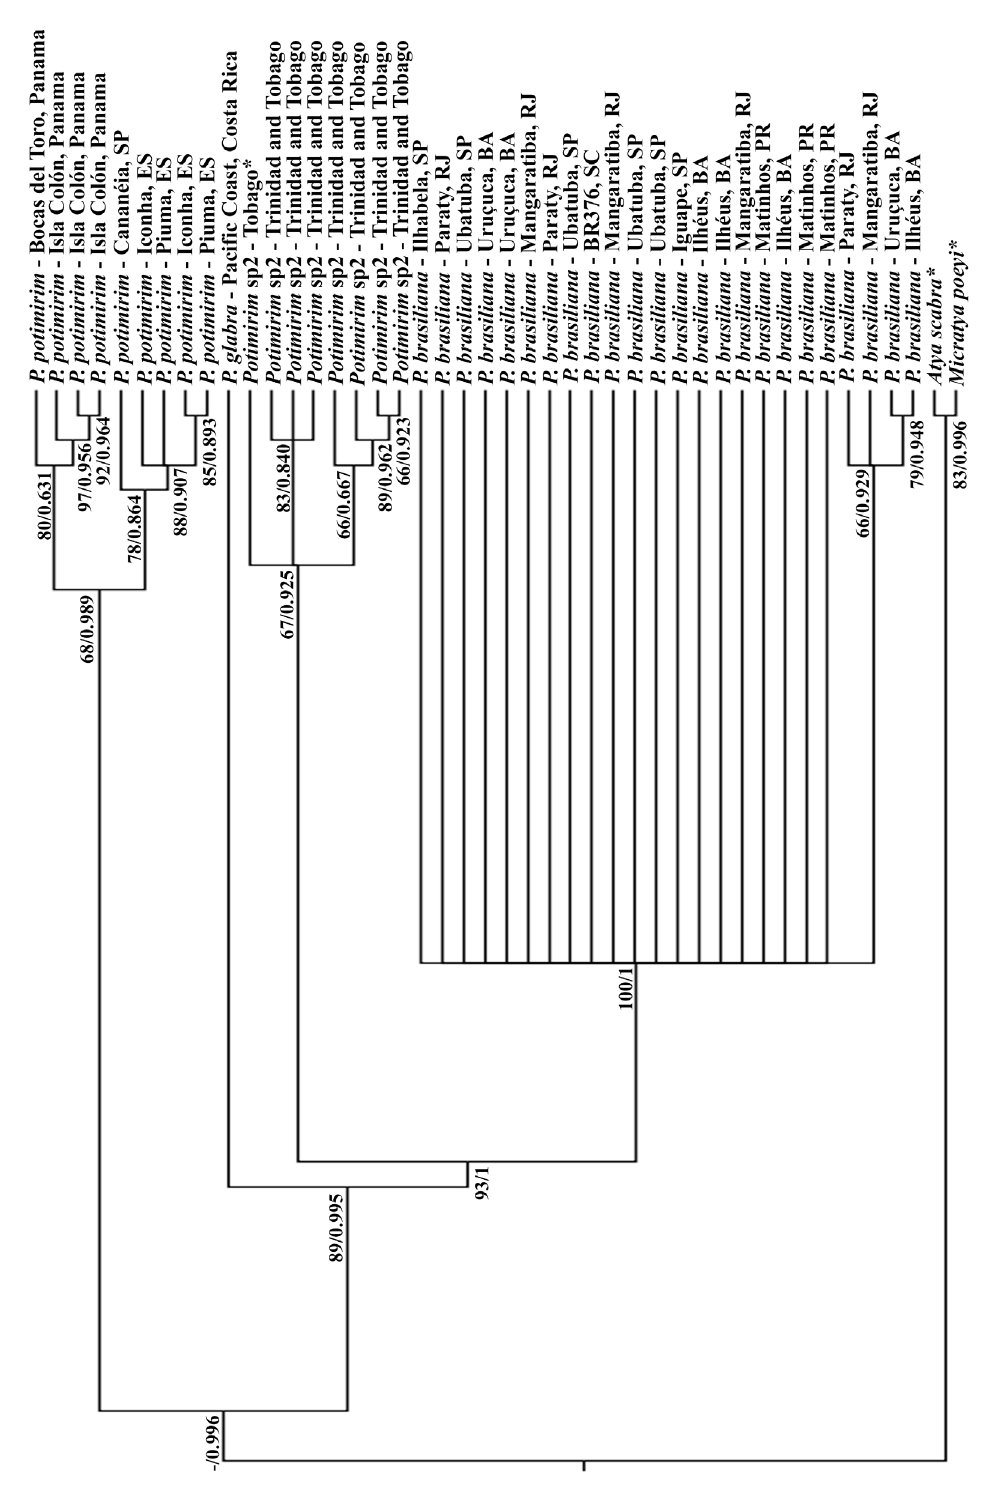
Figure 2. Consensus tree between the maximum likelihood and Bayesian inference based on COI. Node numbers represent the bootstrap values and a posteriori probability. *Sequence from GenBank. BA – Bahia, ES –